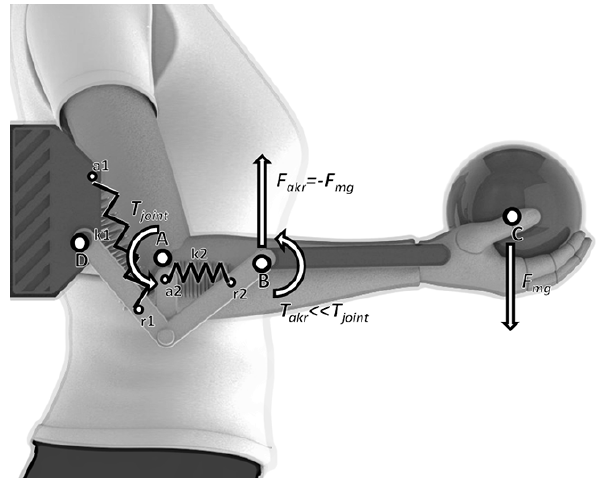
Figure 4. Example of serial akr mechanism used for an elbow sup- port exoskeleton. The user’s elbow join is located at A, a load is applied at point C, and point B is located arbitrarily along the line AC.